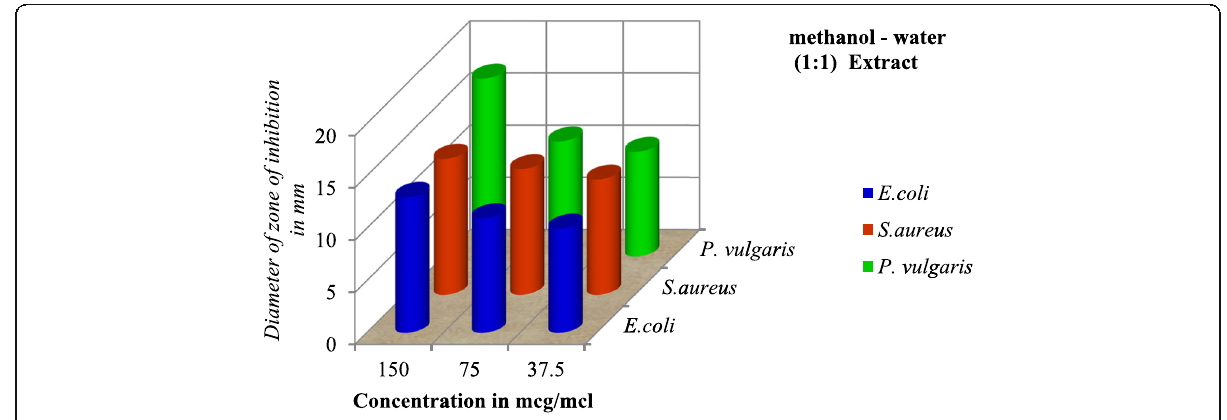
Fig. 5 Antibacterial sensitivity of methanol-water (1:1)